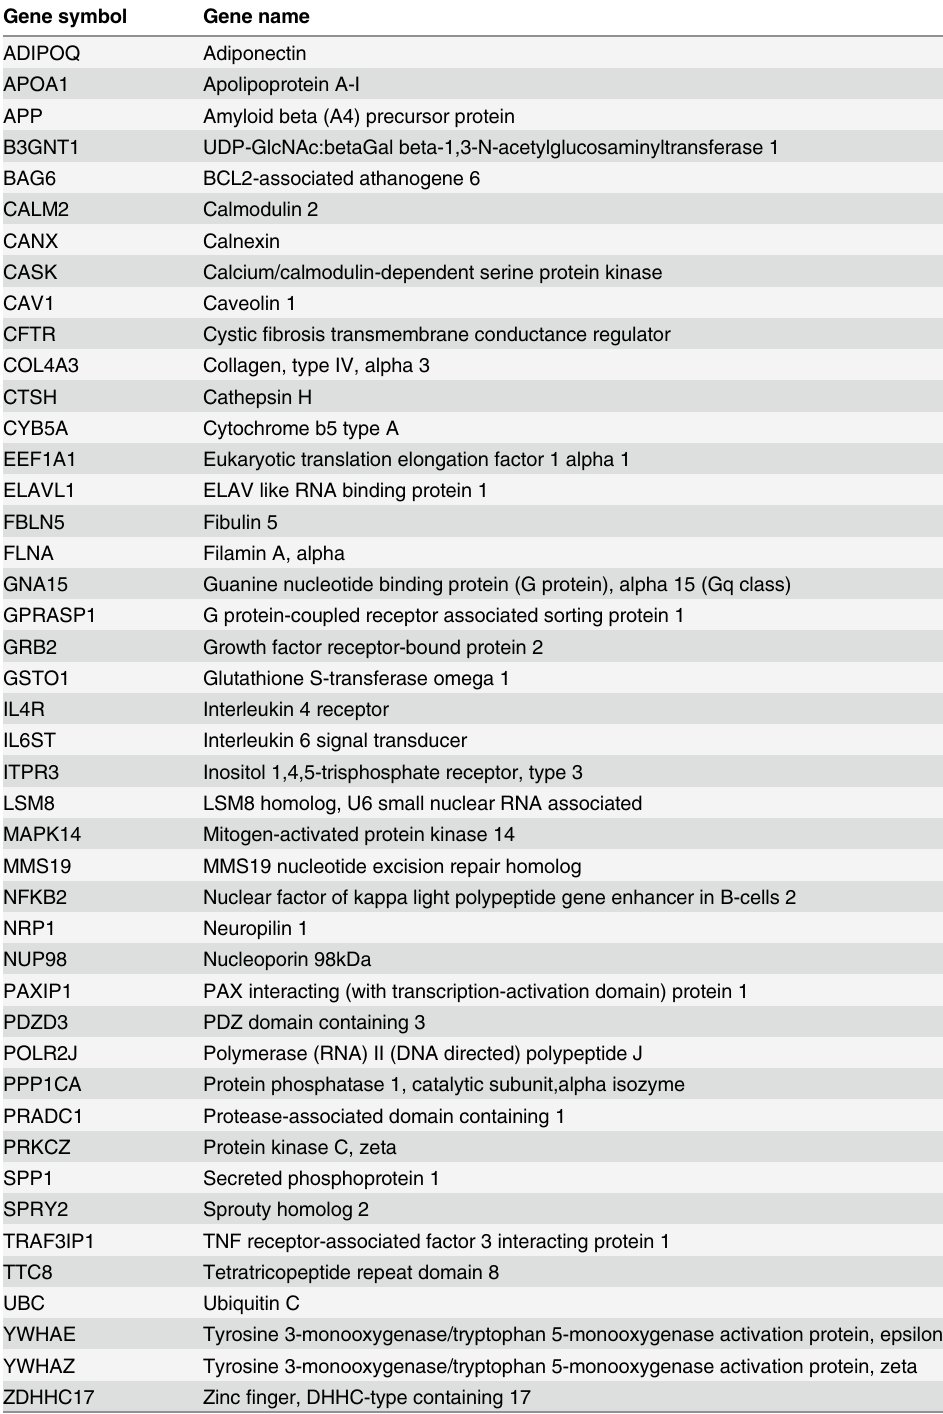
Table 3. Genes included in the NA-specific network but not of